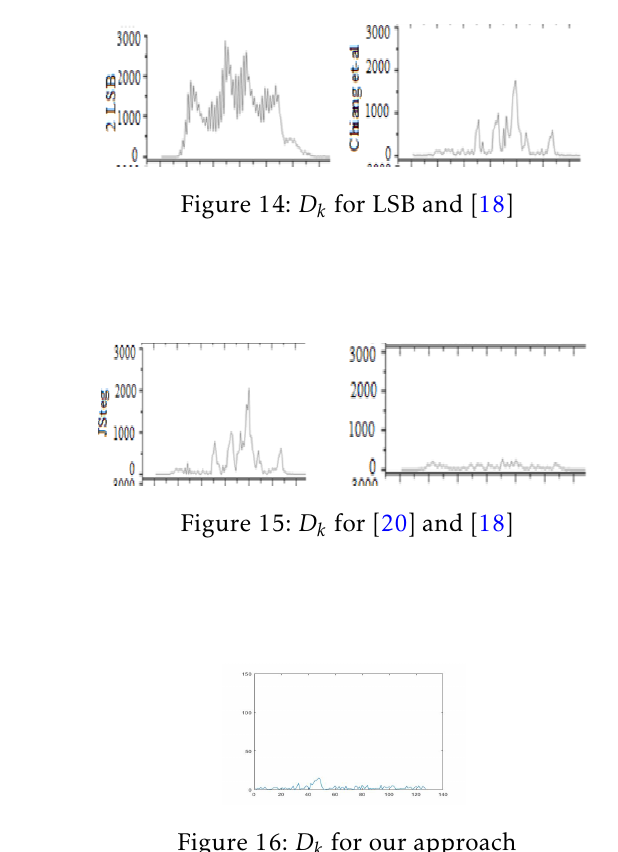
Figure 16: D k for our